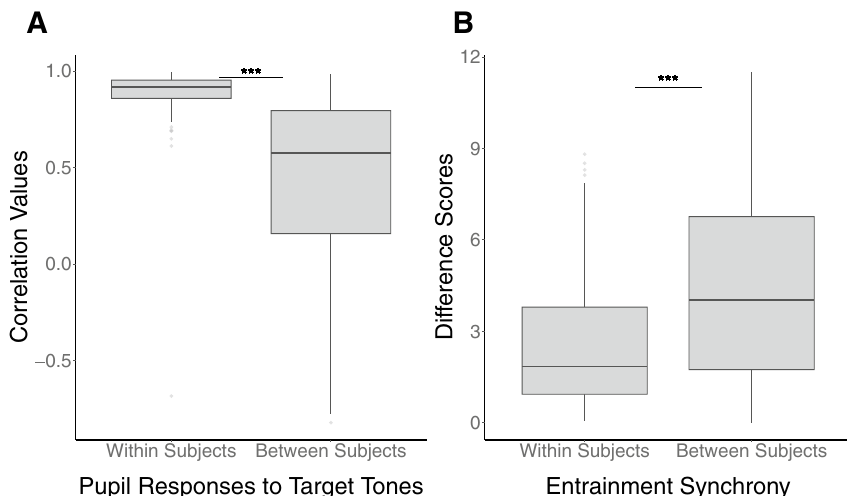
Figure 3. ( A ) Boxplot comparing correlations of pupil response curves to target tones within and between participants. Within-participants correlations (M = 0.89, SD = 0.15) were significantly higher than between- participants correlations (M = 0.44, SD = 0.44; p < 0.001), suggesting that pupil responses for a single individual are both different from other individuals’ and reliably similar across multiple experimental sessions. ( B ) Boxplot comparing difference scores of pupillary entrainment synchrony across the oddball task within and between participants. Within participants difference scores (M = 2.6, SD = 2.18) were significantly lower than between participants difference scores (M = 4.39, SD = 2.97; p < 0.001), suggesting that the intensity with which an individual synchronizes with the temporal dynamics of the oddball task is reliably similar across multiple experimental sessions and different from other